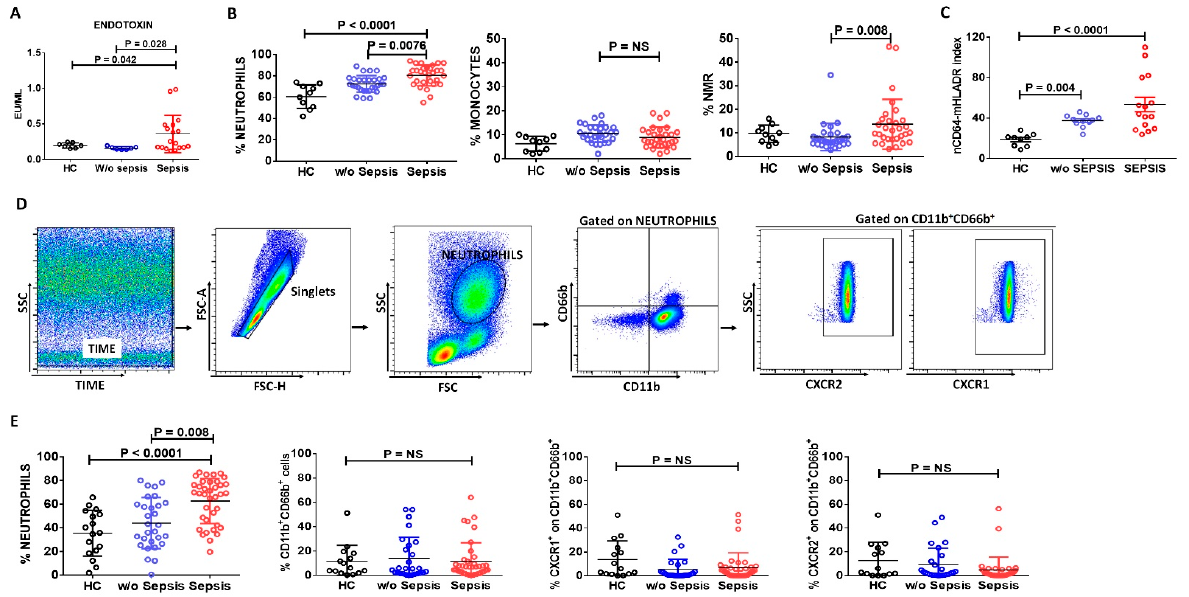
Figure 1. Expression of neutrophils, monocytes, and nCD64-mHLADR Index in patient groups. Scatter dot plot shows ( A ) Endotoxin levels, ( B ) differential leukocyte count (DLC): neutrophils, monocytes, and neutrophils to monocyte ratio (NMR) by analyzing complete blood count and ( C ) nCD64-mHLADR Index between the groups. ( D ) Sequential gating strategy for identification of neutrophils and their activated markers, i.e., CXCR1, CXCR2 and CD66b using flow cytometry. ( E ) Scatter dot plot shows the percent of neutrophils, CD11b + CD66b + , percent of CXCR1 + and CXCR2 + on CD11b + CD66b + between the groups using flow cytometry. Results are expressed as the mean ± SD; One-way ANOVA/Kruskal–wallis test followed by probability adjustment by the Mann–Whitney.